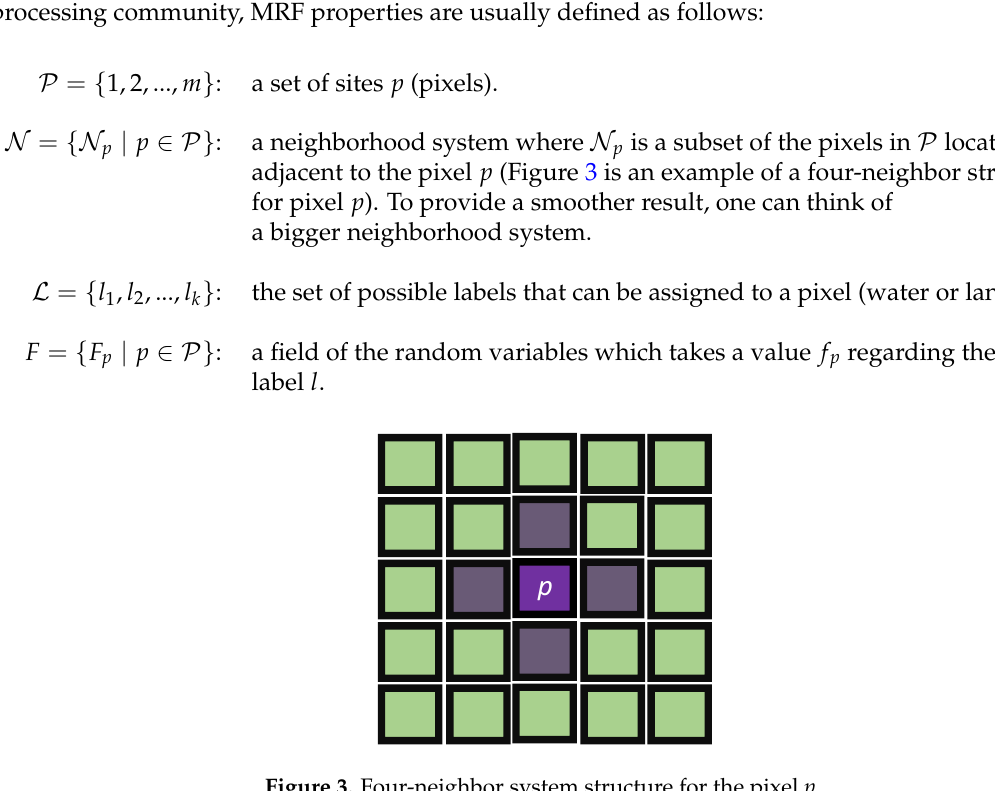
Figure 3. Four-neighbor system structure for the pixel p